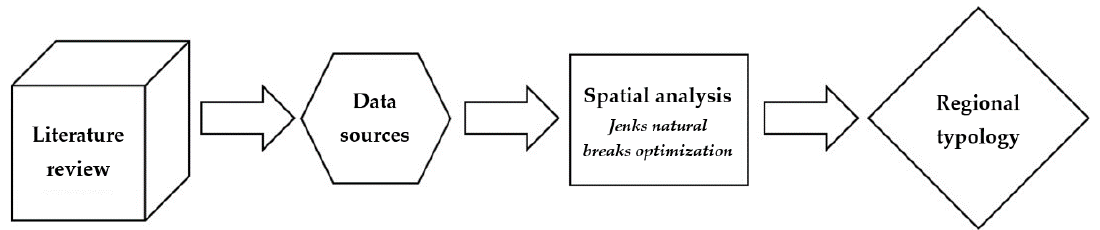
Figure 3. Algorithm of the performed research. Source: own substantiation with the use of [39].